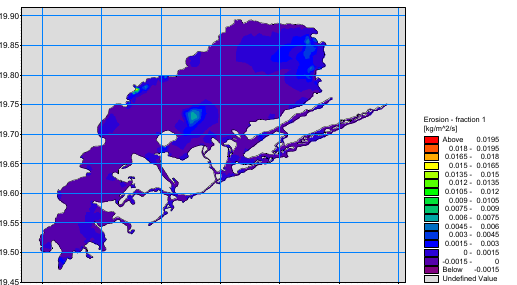
Figure 7h. Simulated spatial profile of Erosion -fraction 1 (kg/m 2 /s)